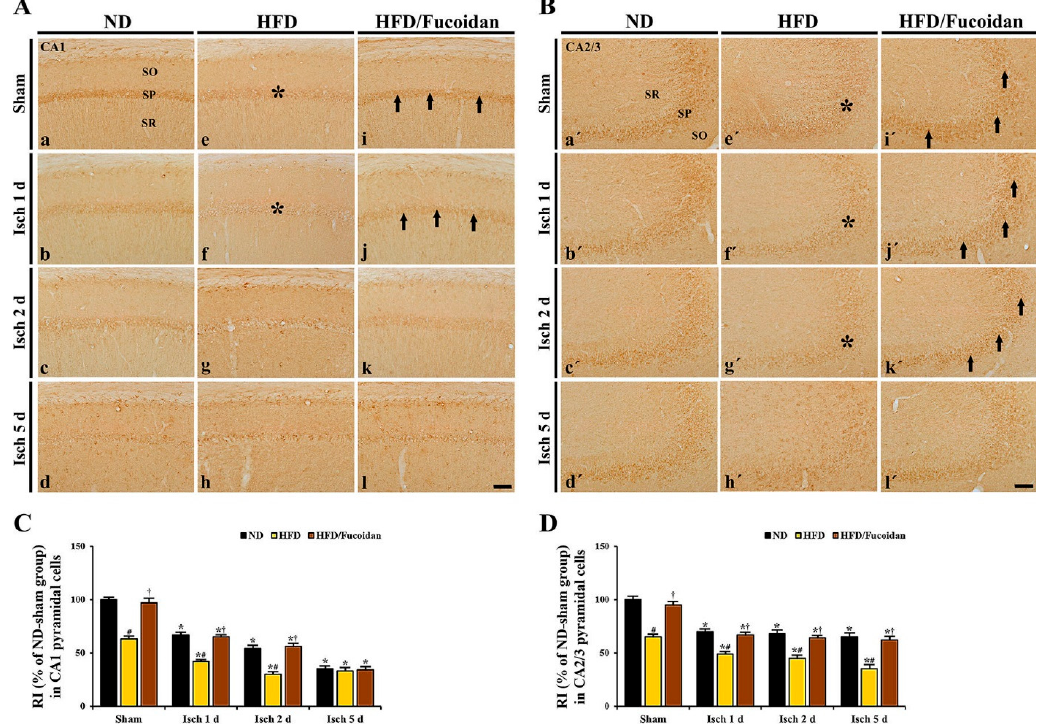
Figure 10. ( A , B ) SOD2 immunohistochemistry in the CA1 ( A ) and CA2/3 ( B ) areas of the ND-fed (left